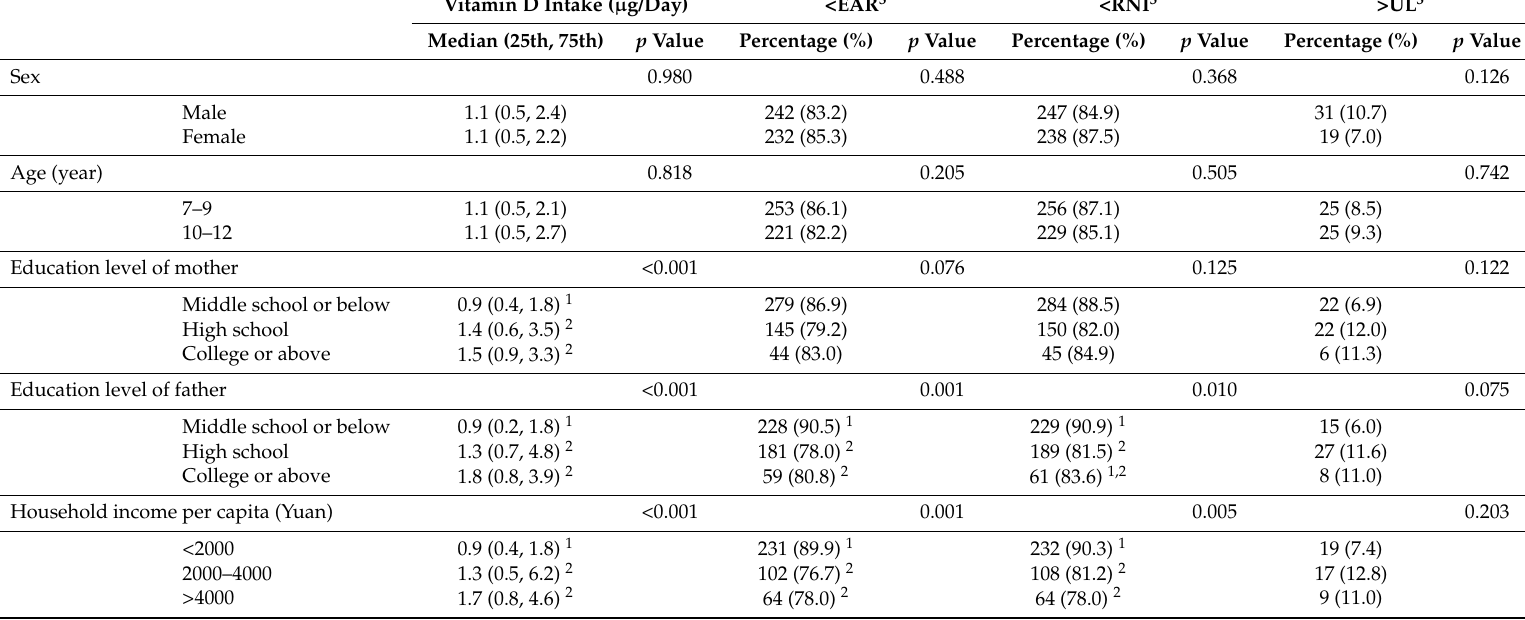
Table 2. Vitamin D intake status of school-age children by relevant